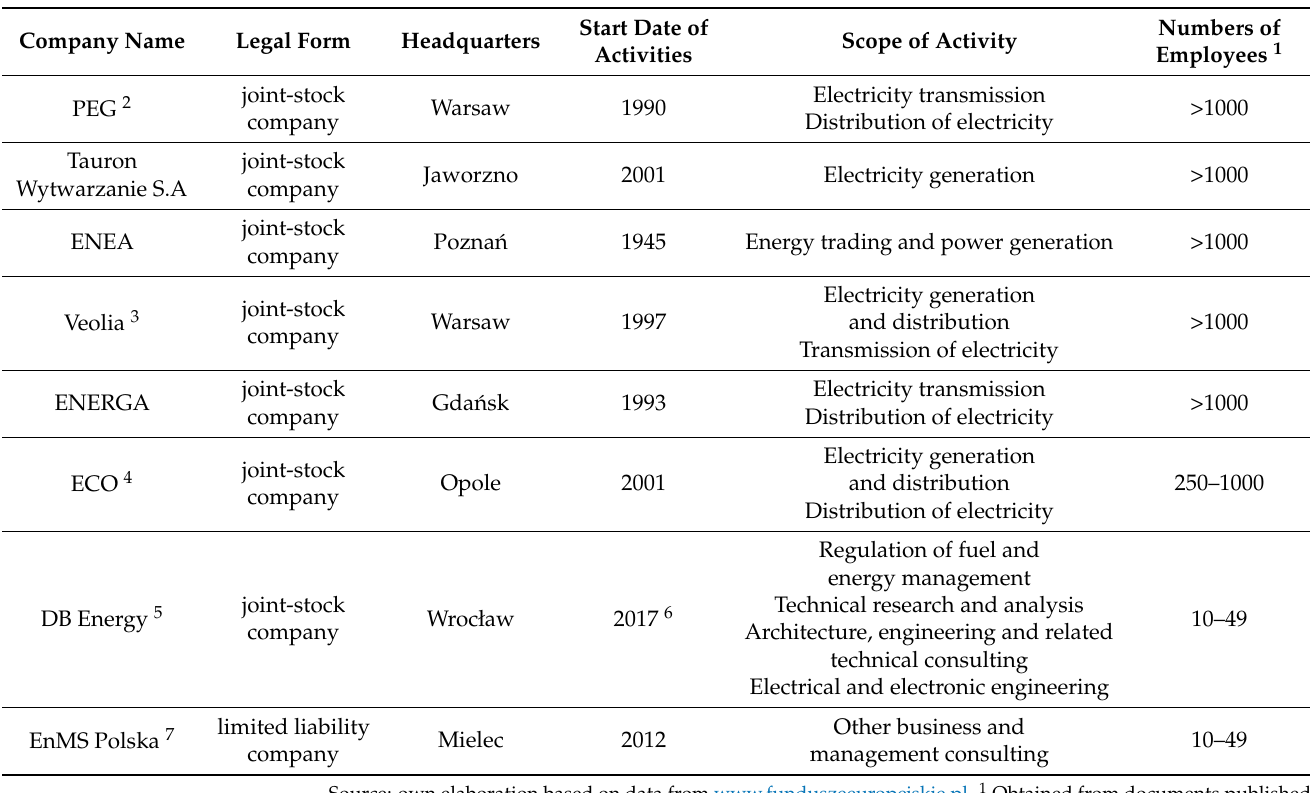
Table 1. Characteristics of enterprises by area of